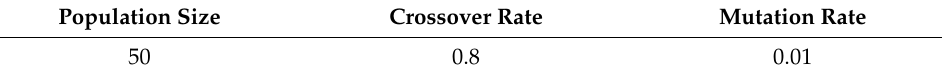
Table 1. GA parameters used in optimization.